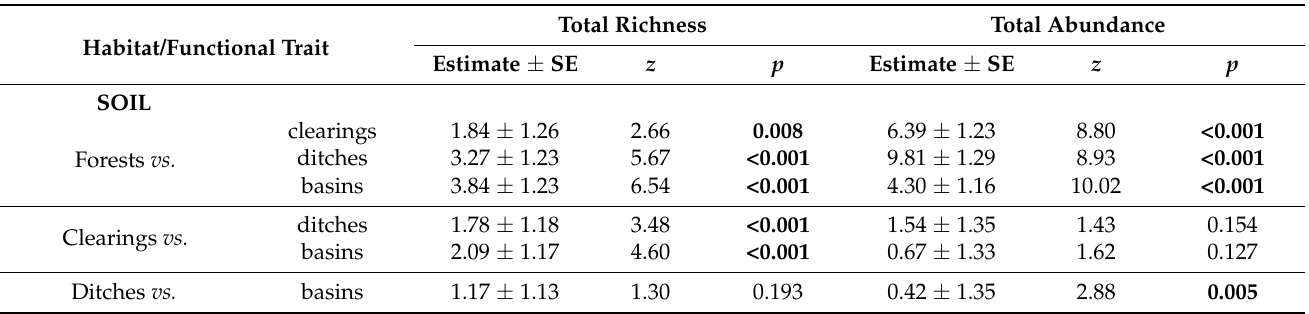
Table 5. Associations between habitat types (forests, clearings, infiltration ditches, infiltration basins) and species richness and abundance of bees differing in nesting preferences (soil, hive, cavity) based on generalized linear mixed models